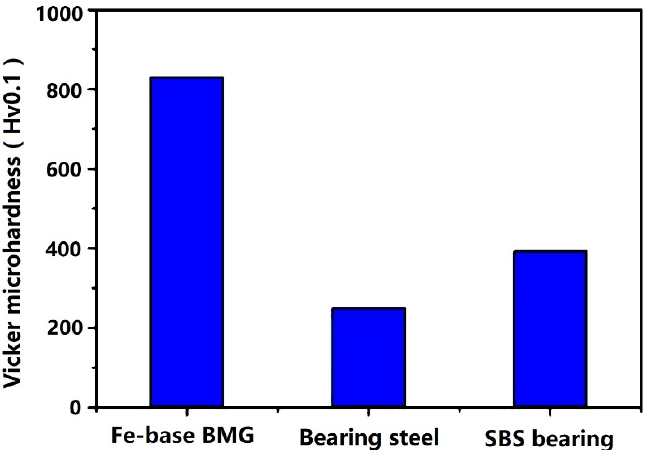
Figure 3. The average microhardness of the Fe-based BMG (bulk metallic glass) coatings, bearing steel, and SBS (steel-backed sintered) bearing. Reprinted with permission from [39] Copyright 2021 Elsevier .